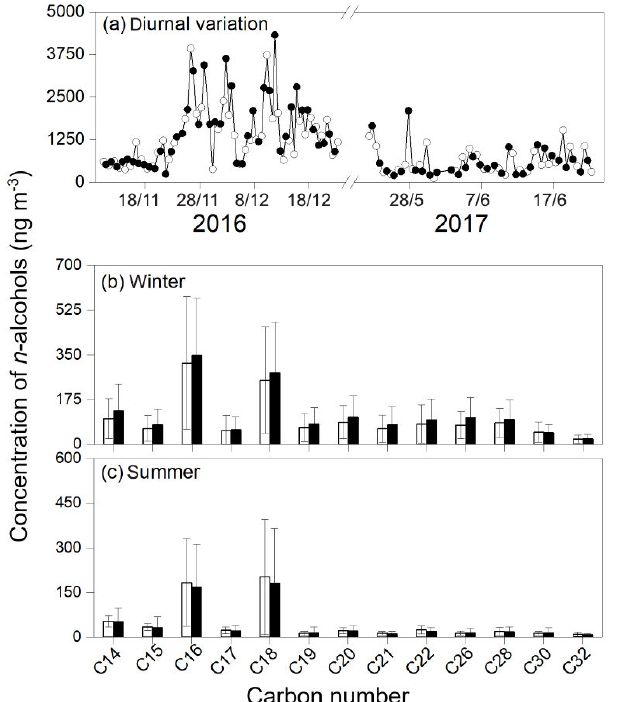
Figure 5. Temporal variations (a) and molecular distributions of n -alcohols during wintertime (b) and summertime (c) in Tianjin (white and black represent day- and night-time samples respec- tively).